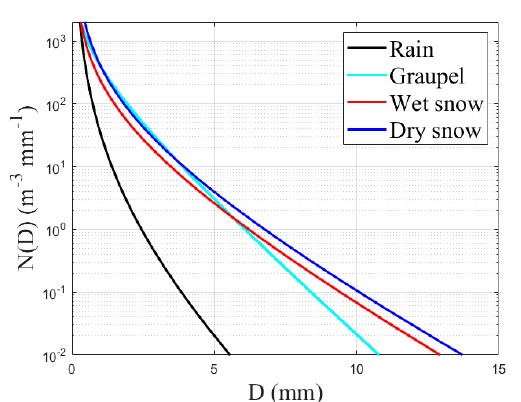
Figure 1. Mean hydrometeor size distributions (HSDs) of rain (black), graupel (cyan), wet snow (red), and dry snow (blue). Table 1. The mean (standard deviation) of the four parameters of rain, graupel, wet snow, and dry snow.